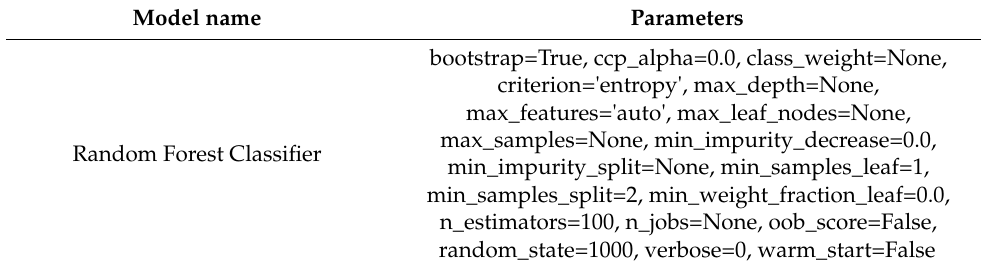
Table 2. Parameters used to build the best performing model.